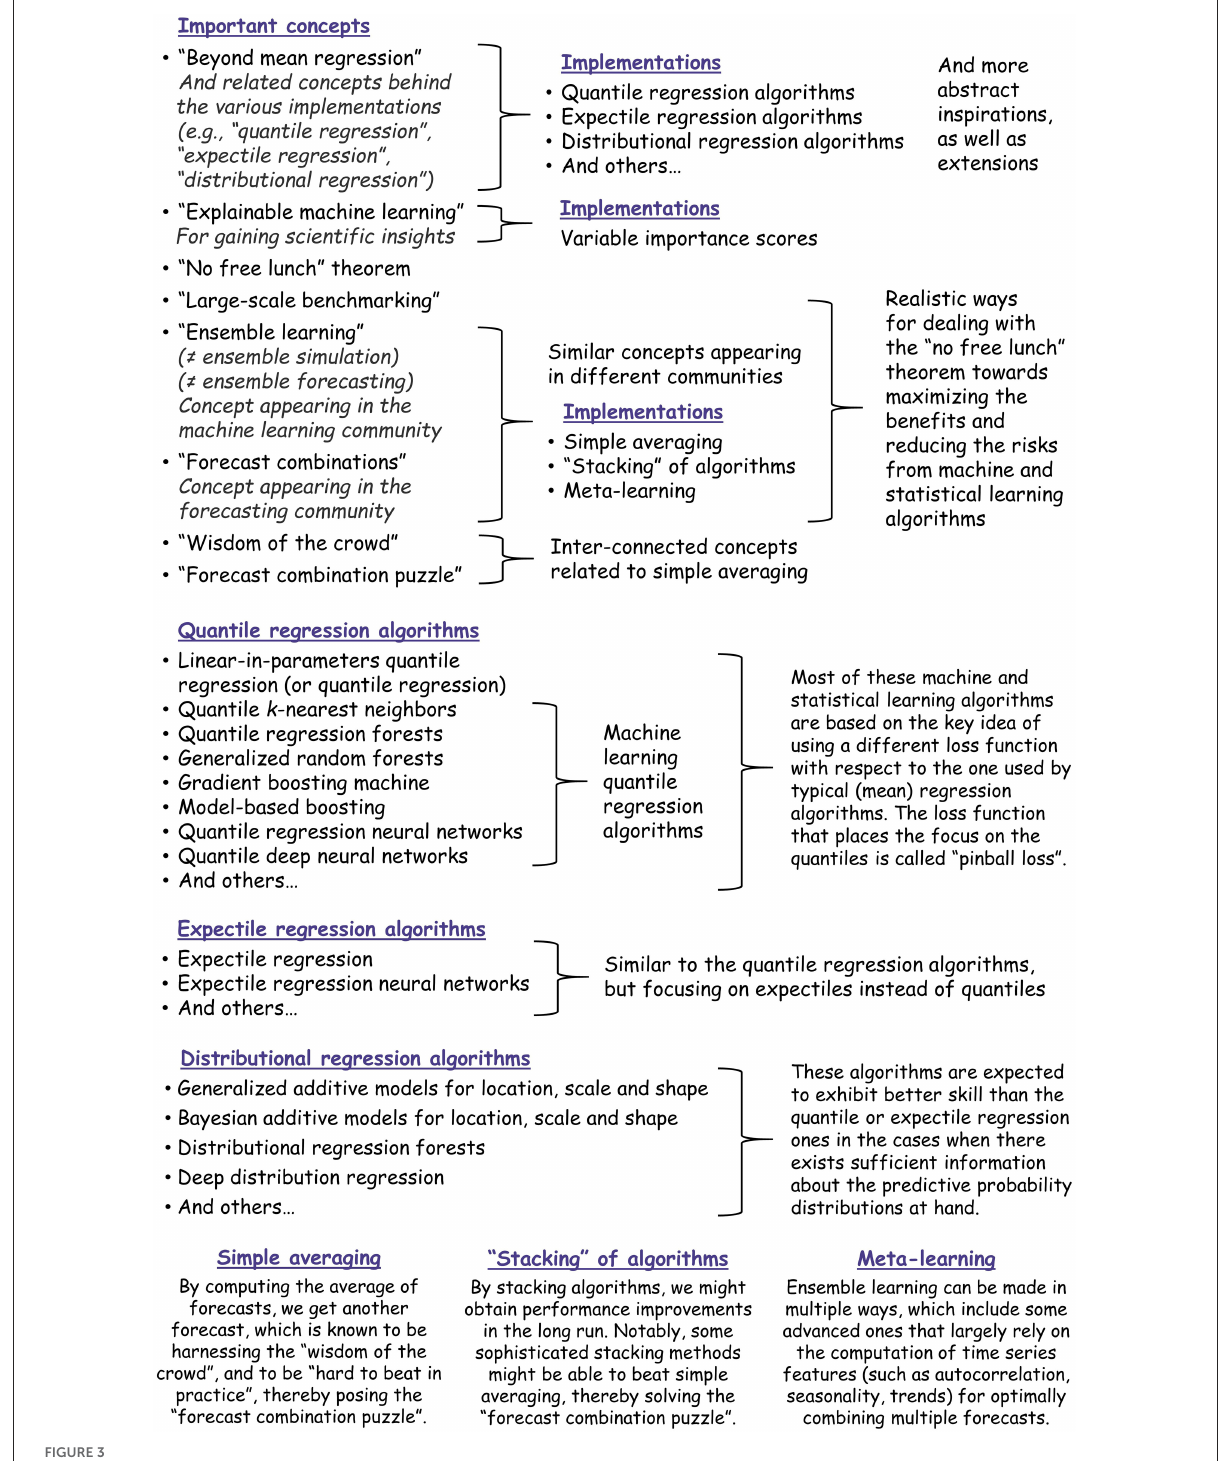
FIGURE3 A practically-oriented synthesis of the most relevant machine learning concepts and methods for performing probabilistic hydrological post-processing and forecasting. The various procedures consisting probabilistic hydrological post-processing, in its basic formulation, are summarized in Figure